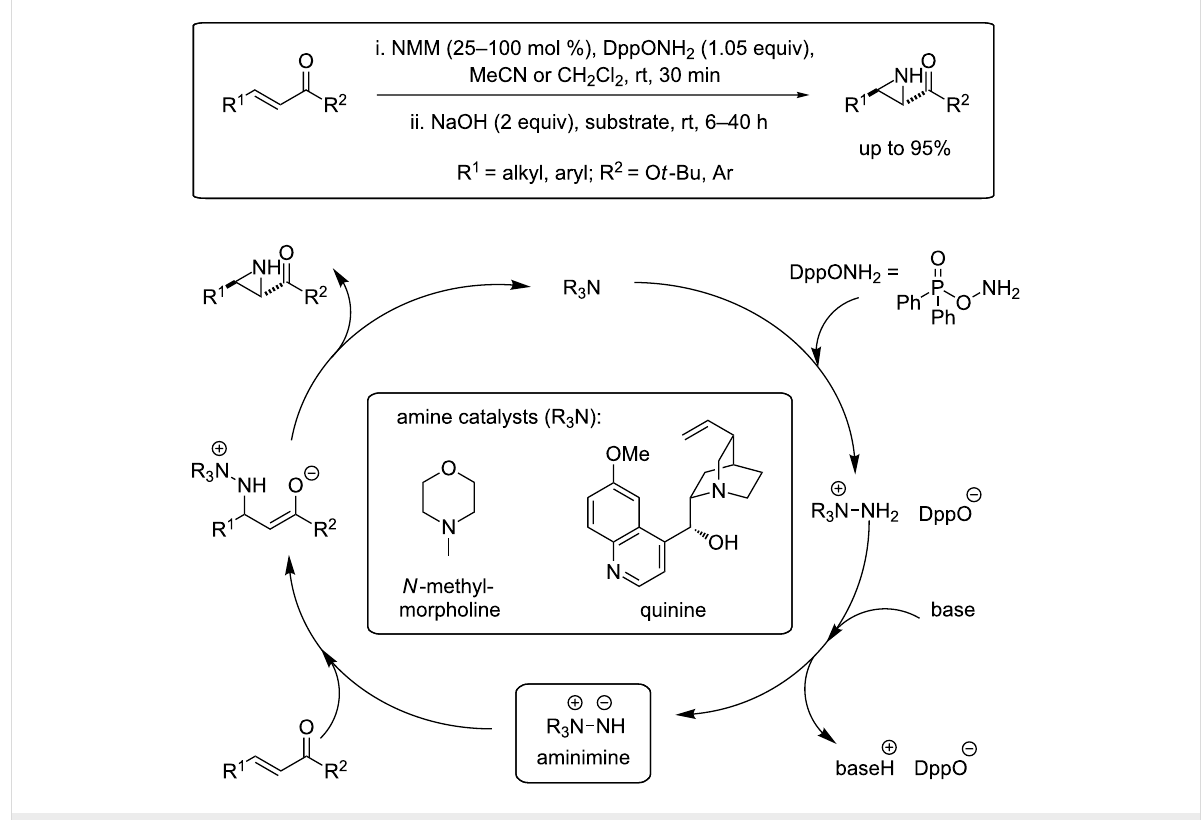
Figure 1: Amine-promoted alkene